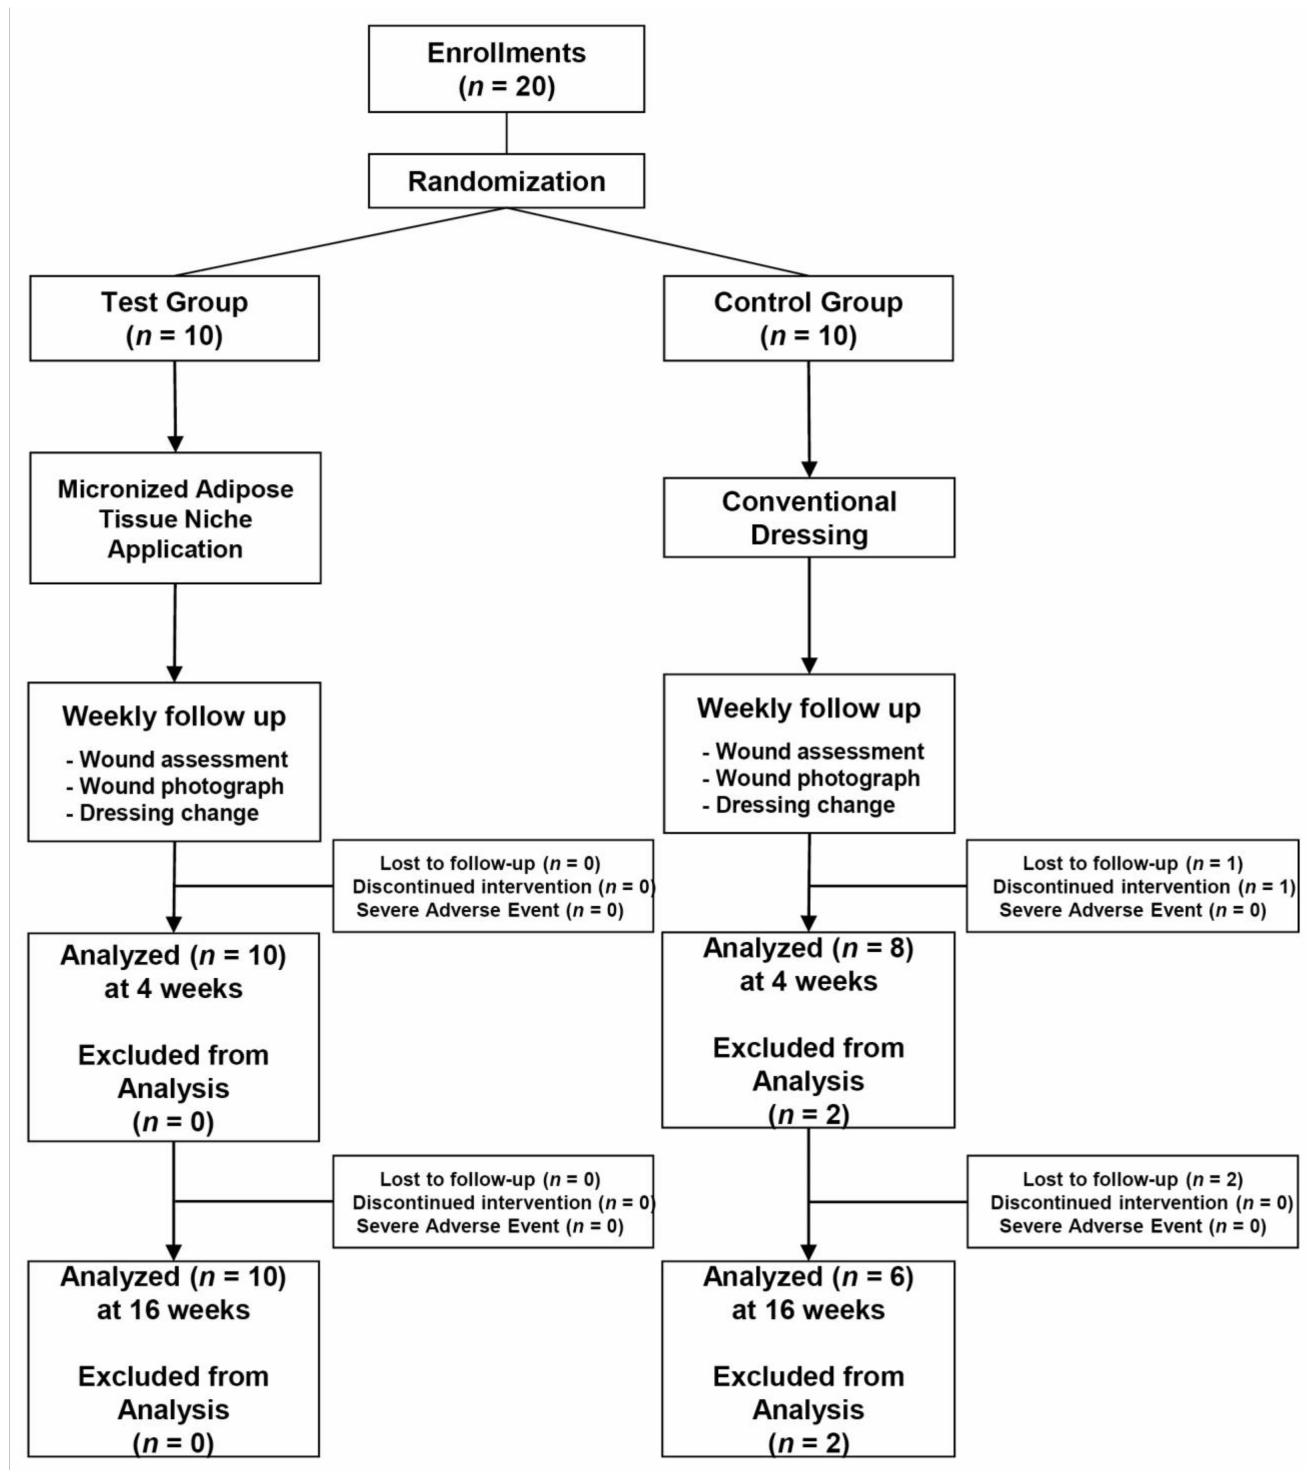
Figure 1. CONSORT diagram showing the flow of patients included in this